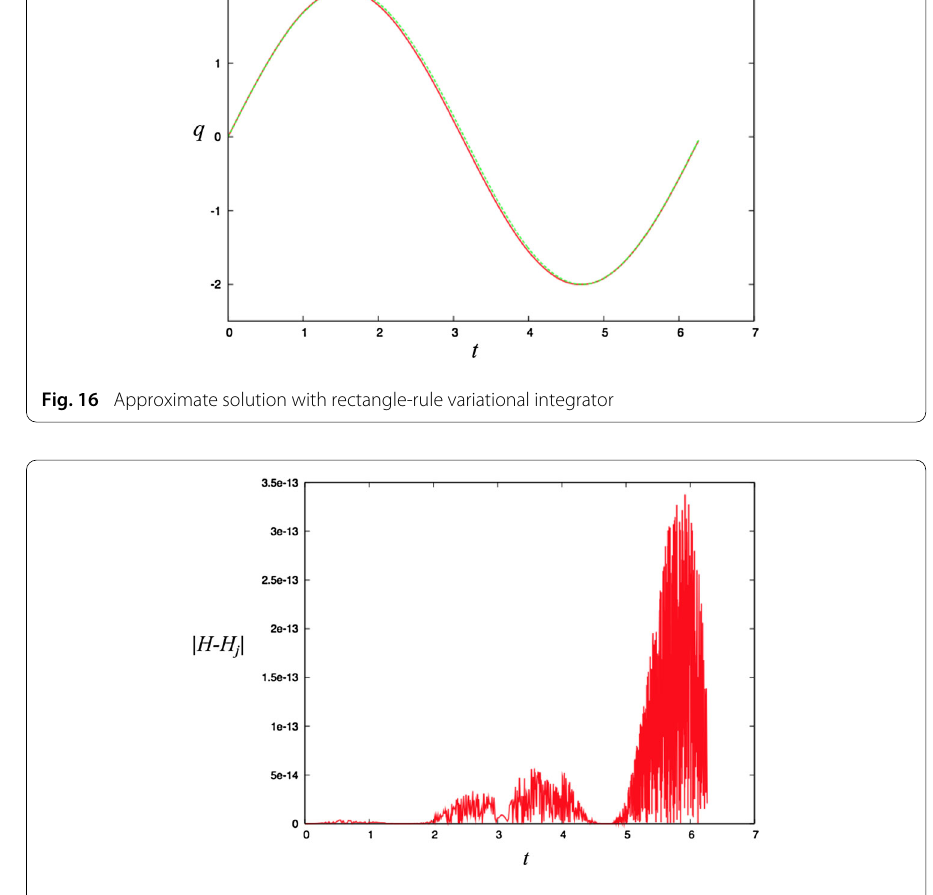
Fig. 17 Error on H with rectangle-rule variational